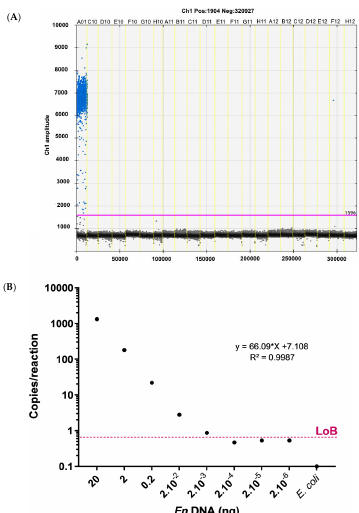
Figure 1. ( A )The limit of blank (LoB) assay. One-dimensional plots of Fn copy numbers by ddPCR. Figure 1. ( A ) The limit of blank (LoB) assay. One-dimensional plots of Fn copy numbers by ddPCR. A01: positive control, C10 to F12: E. coli DNA, and H12: no template control (NTC). ( B ) Serial dilu- tion of Fn DNA in E. coli- background DNA. The number of Fn DNA copies determined by ddPCR were plotted against the corresponding dilutions. A01: positive control, C10 to F12: E. coli DNA, and H12: no template control (NTC). ( B ) Serial dilution 3.3. Detection of Fn DNA by ddPCR and Comparison with qPCR of Fn DNA in E. coli -background DNA. The number of Fn DNA copies determined by ddPCR were Based on the LoD, a sample was considered positive for Fusobacterium nucleatum DNA when it had more than 2.7 copies/reaction. Overall, of the 139 CRC FFPE samples evaluated, 38.8% (54/139) were positive for the presence of Fn DNA by ddPCR (Figure plotted against the corresponding S3). Next, the Fn levels measured by ddPCR were compared with those previously re- ported by quantitative PCR (qPCR) in the same FFPE CRC cases [19]. Based on the median number of copies/reaction obtained from the cases exhibiting a presence of Fn DNA